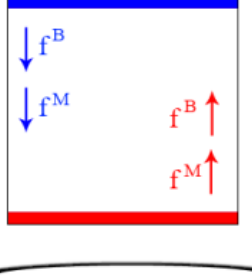
Figure 1. A schematic view of the buoyancy and magnetic forces acting on a fluid in the present research.